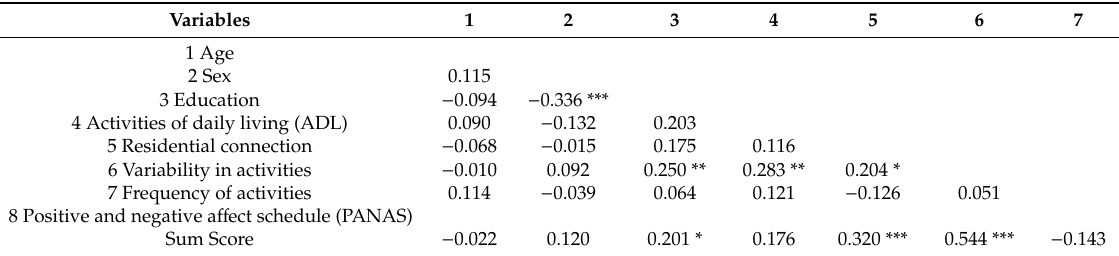
Table 3. Correlation